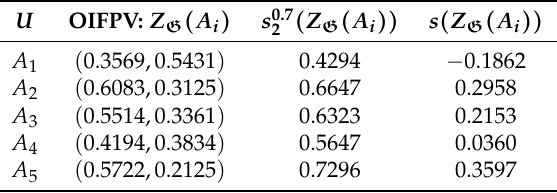
Table 2. OIFPVs and their corresponding